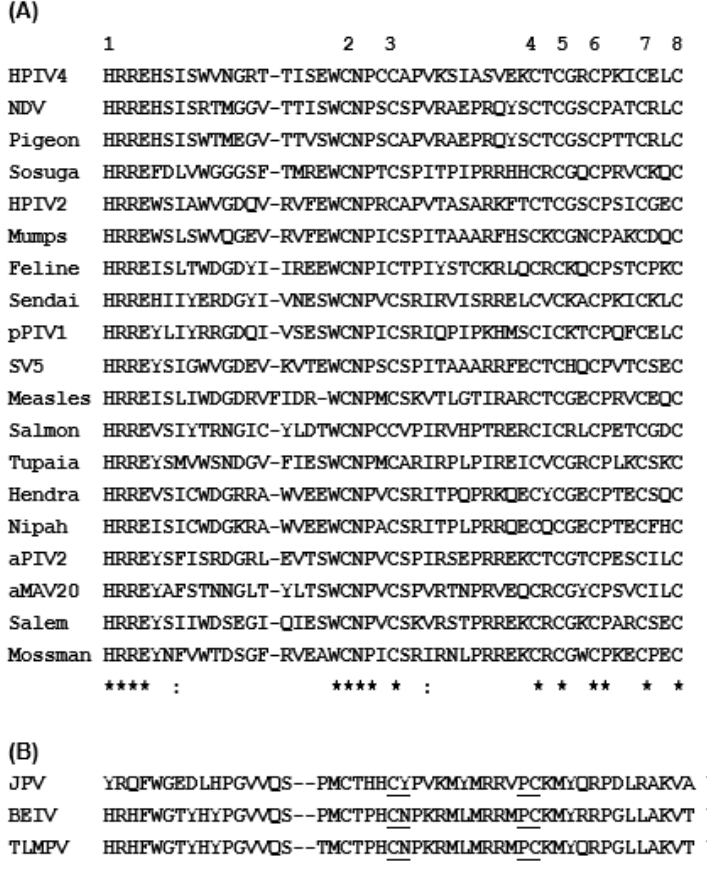
Figure 4. Conserved Cys-rich C-terminal domain (CTD) of the Paramyxoviridae V proteins. ( A ) Multiple alignment of the V protein primary structures was performed with Clustal Omega [104]; the invariant residues are asterisked, and one His and seven Cys residues that together coordinate two zinc ions to form a pair of zinc fingers are highlighted [100–103,105,106]. The numbers 1 through 8 on top indicate the eight residues of the zinc finger. Note the invariant Trp and the abundance of Pro residues, which may also be relevant to structure and function. The lack of helical structure in the zinc finger (Figure 5) is certainly in accord with the high concentration of Pro, a well-known helix breaker. The GenBenk accession numbers are (from top to bottom): AFB82774.1 (human parainfluenza virus 4), AHN08005.1 (Newcastle disease virus), ACK38030.1 (pigeon paramyxovirus 1), YP_009094030.1 (Sosuga virus), BAE00052.1 (human parainfluenza virus 2), AYI58047.1 (mumps virus), AFH55521.1 (feline morbillivirus), BAC79143.1 (Sendai virus), QCY53471.1 (porcine parainfluenzavirus 1), QCI44206.1 (SV5), ABB71650.1 (measles virus), AFF60403.1 (Pacific salmon paramyxovirus), NP_054692.1 (Tupaia paramyxovirus), NP_047108.1 (Hendra Henipavirus), NP_112023.1 (Nipah Henipavirus), ADK25231.1 (Avian parainfluenzavirus 2 or Avian metaavulavirus 2), YP_009553490.1 (Avian metaavulavirus 20), YP_009094333.1 (Salem virus), NP_958050.1 (Mossman virus). A combination of common and updated virus names were used to conserve space as well as to avoid identical abbreviations. Since these viruses are distributed over multiple genera, the zinc finger appears to be a general feature in this family, with exceptions shown below. ( B ) The three viruses of the Paramyxoviridae family were recently discovered in rodents and were placed in the genus Jeilongvirus [107]; these three (J-virus, JPV; Beilong virus, BEIV; Tailam virus, TLMPV) do make V proteins by RNA editing, but several zinc-coordinating residues in their CTD (see Figure 4) are naturally altered (shown in red color) so that the zinc finger cannot form [100]. All three are missing zinc-coordinating Cys residues #5, #6, #7, and #8 (also see Figure 5); JPV is additionally missing #1 i.e., His. To conserve space in the multiple alignment, I removed five residues from the underlined regions in each jeilongvirus sequence and display removed ones on the right; for example, in JPV, the dipeptide YS was present between C and Y as CYSY, and the tripeptide QSV was between P and C as